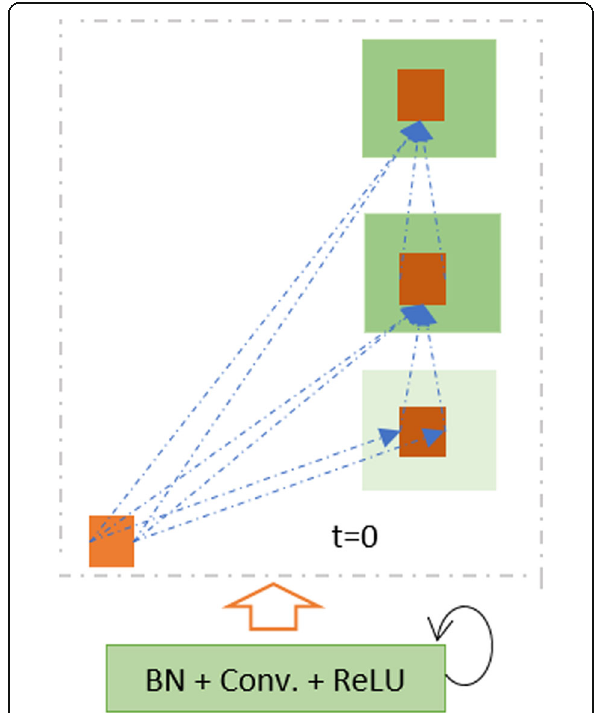
Fig. 3 Unfolded recurrent convolutional layer for time step t =